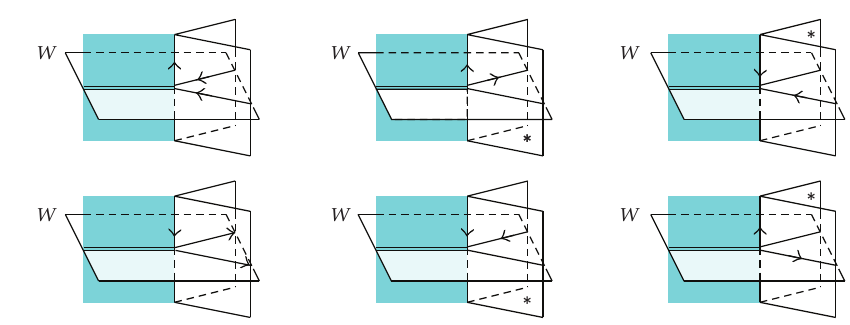
Figure 2: Orientations near a singular